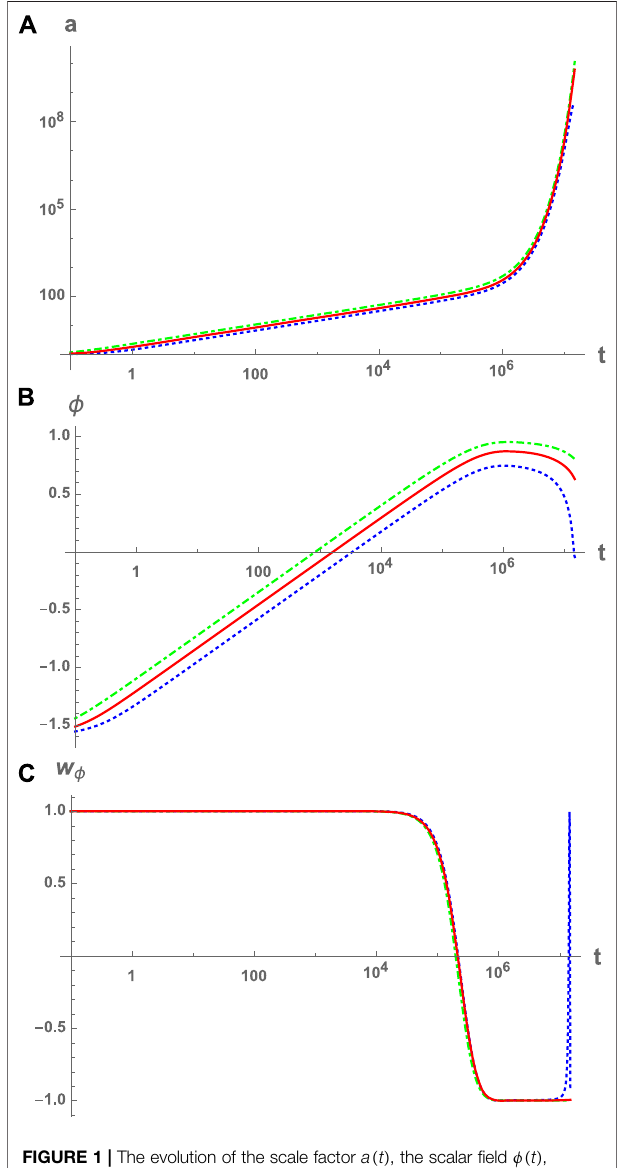
FIGURE 1 | The evolution of the scale factor a ( t ) , the scalar fi eld ϕ ( t ) , andtheequation w ϕ ofstateofthescalar fi eld (A – C) inthepost-bouncephase are depicted and compared among the three modes, LQC (red solid curves), mLQC-I (blue dotted curves) and mLQC-II (green dot-dashed curves), with the Starobinsky potential. In the last panel, w ϕ is de fi ned via w ϕ ≡ P ( ϕ ) / ρ ( ϕ ) (cid:2) [ _ ϕ 2 − 2 V ( ϕ )] / [ _ ϕ 2 + 2 V ( ϕ )] . The initial condition for the simulation is chosen at the bounce with ϕ B (cid:2) − 1 . 6 m pl , _ ϕ B > 0(Li et al., 2019).